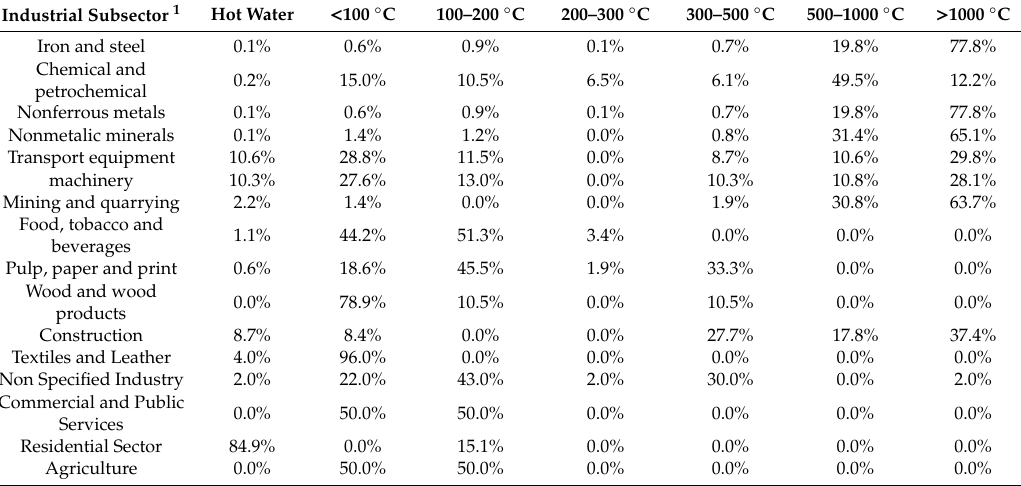
Table A2. Share of the di ff erent temperature levels for heat demand (without space heating) per sector (Source: [113,124,125]. Commercial and public services, as well as agriculture are estimated). Industrial Subsector